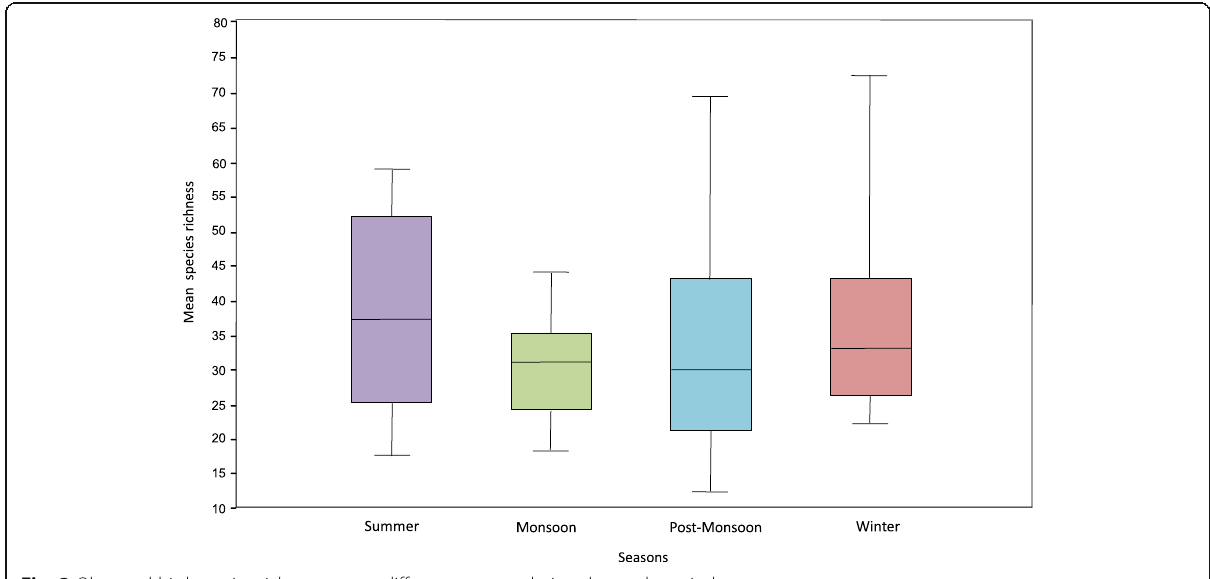
Fig. 3 Observed bird species richness across different seasons during the study period